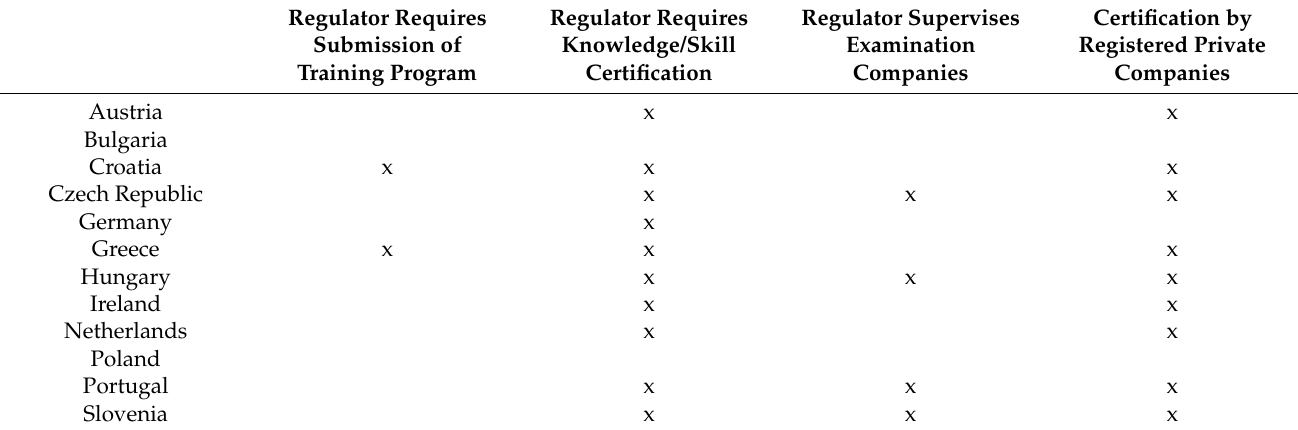
Table 5. Professional qualification regulation overview in selected European Union (EU) countries. Regulator